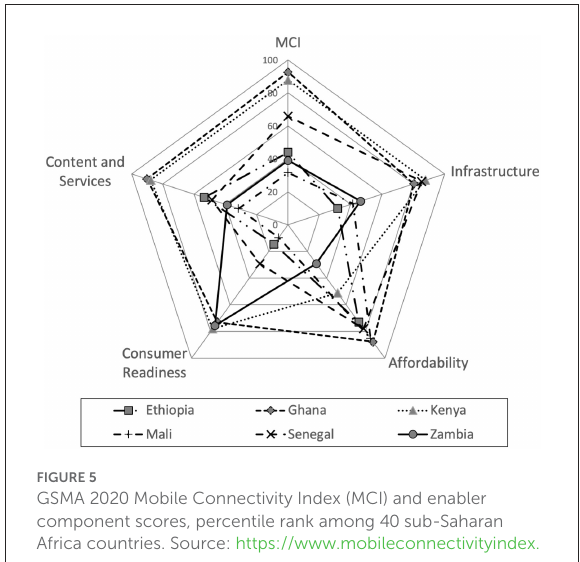
FIGURE5 GSMA 2020 Mobile Connectivity Index (MCI) and enabler component scores, percentile rank among 40 sub-Saharan Africa countries. Source: https://www.mobileconnectivityindex.